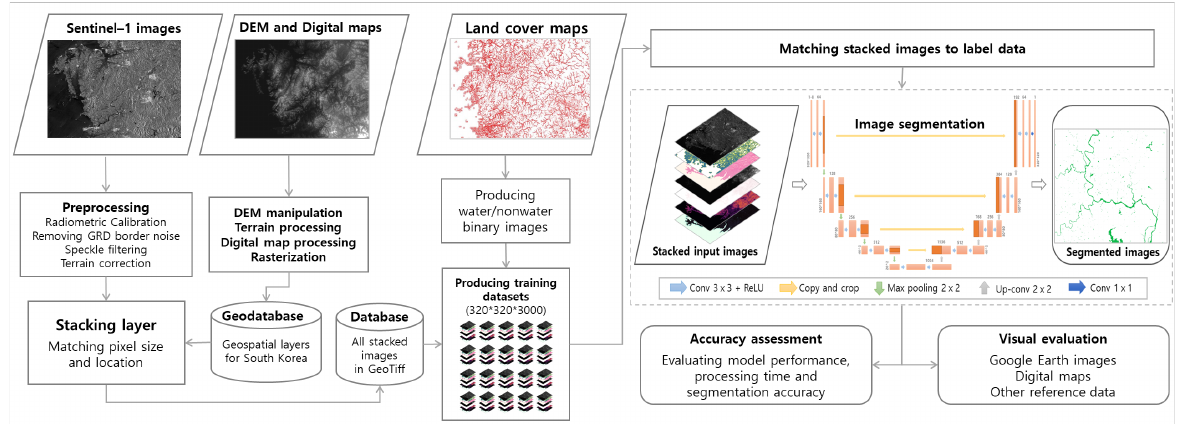
Figure 2. Algorithm of the deep learning-based waterbody extraction in this research (These steps include preprocessing of satellite data, producing geospatial layers, and producing training data using land cover maps, deep learning model training and inference, and accuracy assessment.).